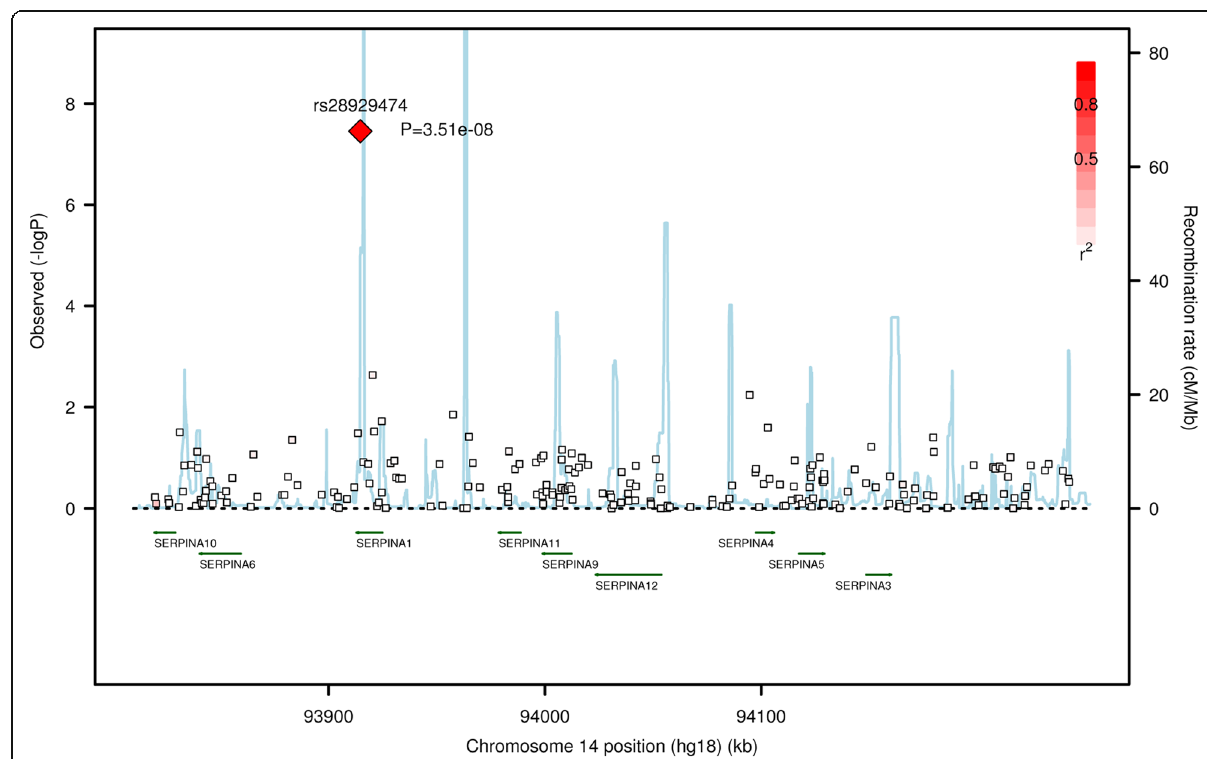
Fig. 2 Association plot of SERPINA1 region with post-bronchodilator percent predicted FEV 1 . Negative logarithm-transformed P value ( left ) and recombination rate ( right ). Red color scale represents the strength of linkage disequilibrium of SNPs with